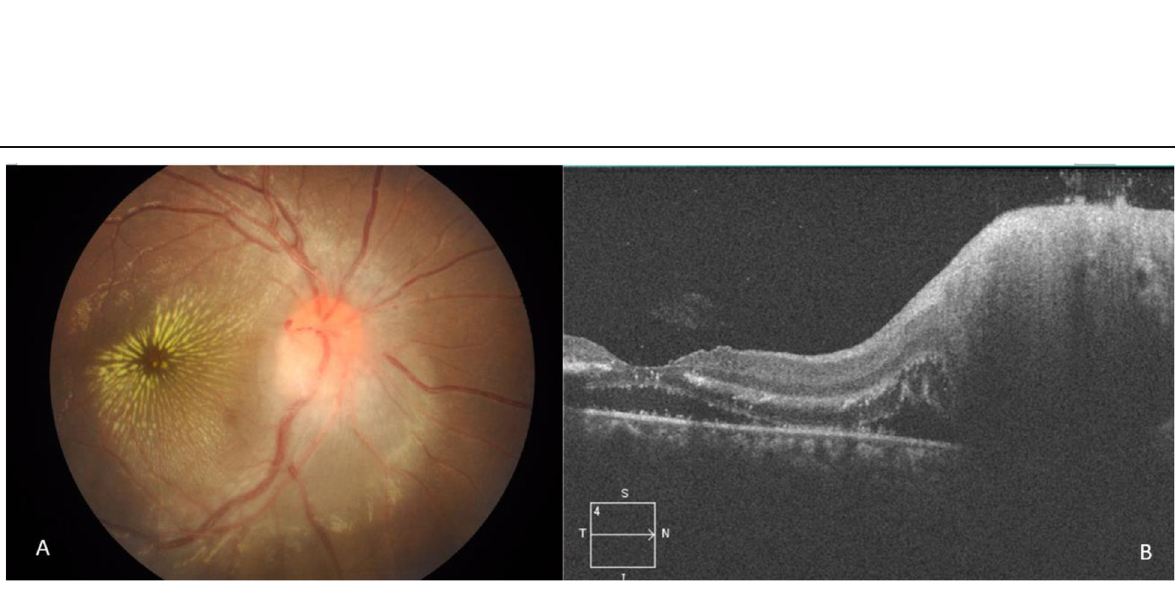
Fig. 2 Patient no. 4. a Colour fundus photograph of the right eye: peripapillary retinal oedema with prominent macular star (typical neuroretinitis), splinter haemorrhage near the margin of the disc with tortuous and markedly dilated retinal vessels. b SD-OCT of the same eye: showing swollen ONH with SRF causing exudative retinal detachment involving the fovea. Hyperreflective spots within the OPL correspond to the macular star